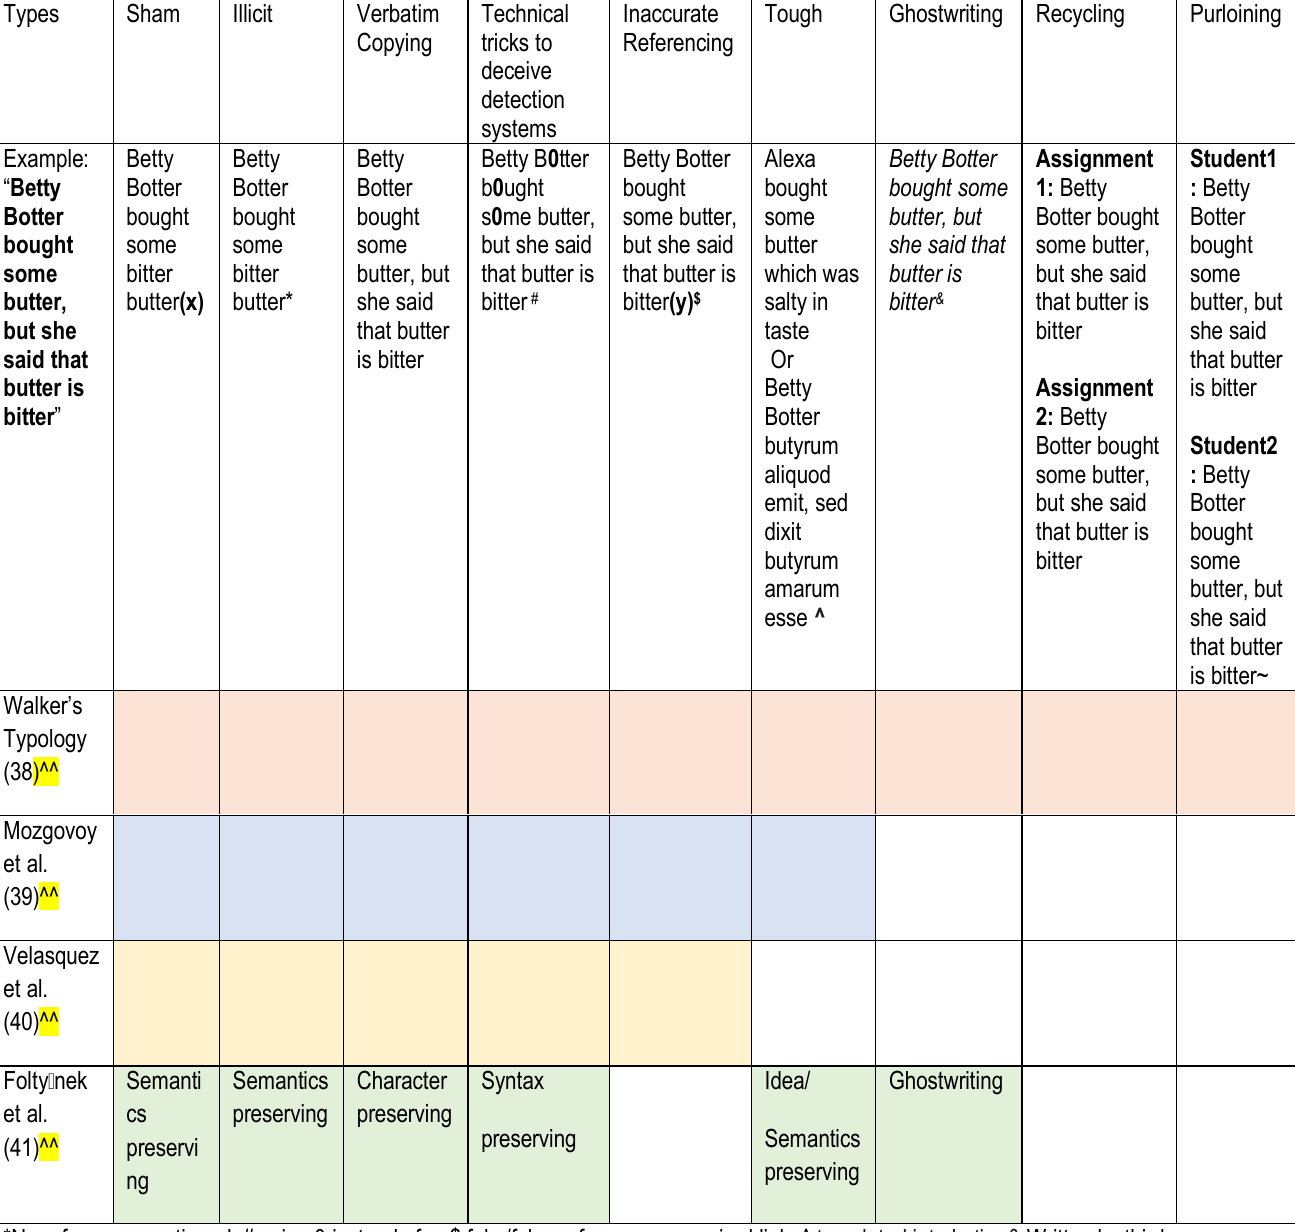
Table 1: Different approaches for classification of